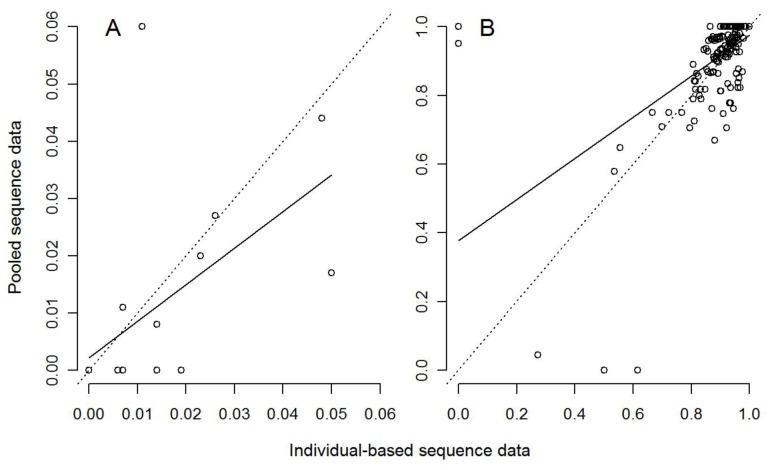
Relationship between pooled and individual approaches for estimating A) nucleotide diversity (π, N = 20 populations shown) and B) pairwise population differentiation (FST,
N = 190 population-pairs shown) from Leiopelma hochstetteri 830-bp Cyt b mtDNA data.The dotted lines are the expected relationship where β = 1 (i.e. the two approaches give identical estimates), the solid lines are the observed linear regression (Table 1).